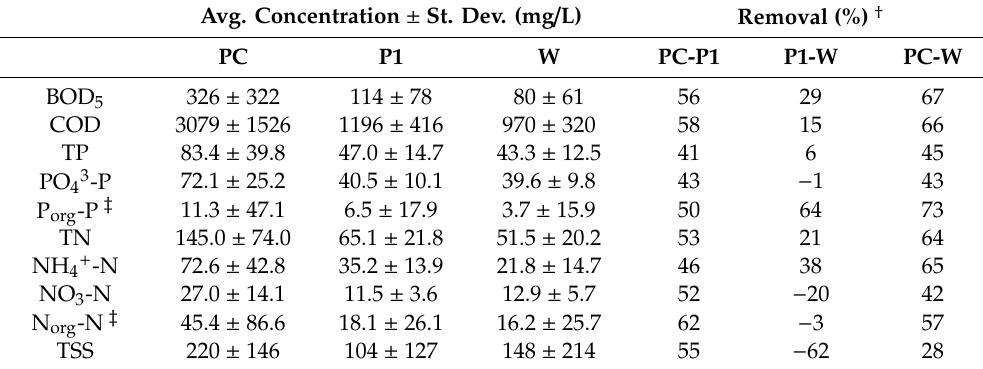
Table 2. Mean concentrations and removal e ffi ciencies for the operating season (May 5 to Nov 15,